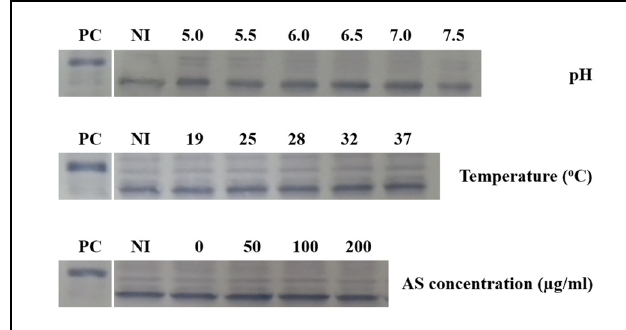
FIGURE 5 | Expression of vbp3 in the double-mutant ( vbp1 and vbp2 ) strain GMV12 at different pHs, temperatures and AS concentrations. A. tumefaciens strain GMV12 cells were induced under the indicated pH, temperature or AS concentration. Crude extracts from the differentially induced GMV12 cells were separated using SDS-PAGE and then analyzed by Western blotting with antibody against VBP3. PC, positive control, crude extract from E. coli cells expressing vbp3 with His-tag. NI: crude extracts from GMV12 cells not induced in IB medium.